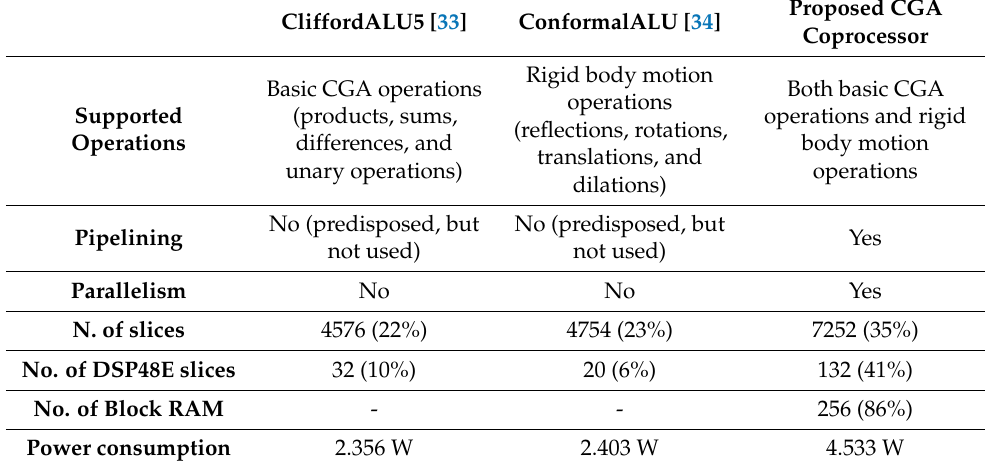
Table 15. Comparison of CliffordALU5, ConformalALU, and the proposed CGA coprocessor. Re- ported performance figures are related to the implementation of the three coprocessors on the same Xilinx Virtex-5 XC5VFX130T FPGA device. CliffordALU5